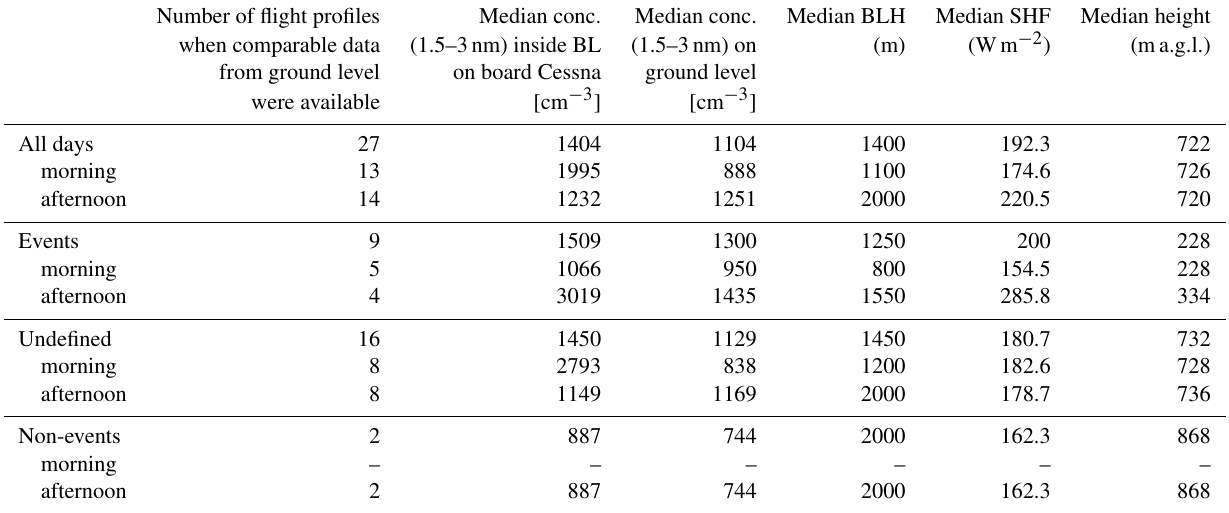
Table 1. Numerical statistics for boundary layer height (BLH) and sensible heat flux (SHF), indicating the mixing of air mass, and concen- trations of 1.5–3nm particles together with median measurement heights during measurement flights in 2015 and 2017. The morning flights were conducted between 07:00 and 12:00 and afternoon flights at 12:00–15:00. The low number of flights during non-event days is caused by cloudiness, which makes the operation of the aircraft